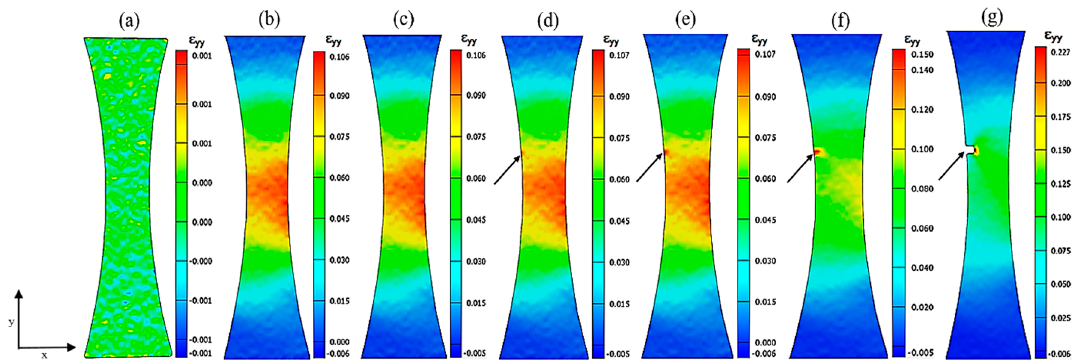
Figure 17. DIC Images of specimen 3: ( a ) reference stage, ( b ) at 1000 s, ( c ) at 21556 s, ( d ) at 22911 s, ( e ) at 23250 s, ( f ) at 23590 s and ( g ) at 23928 s.